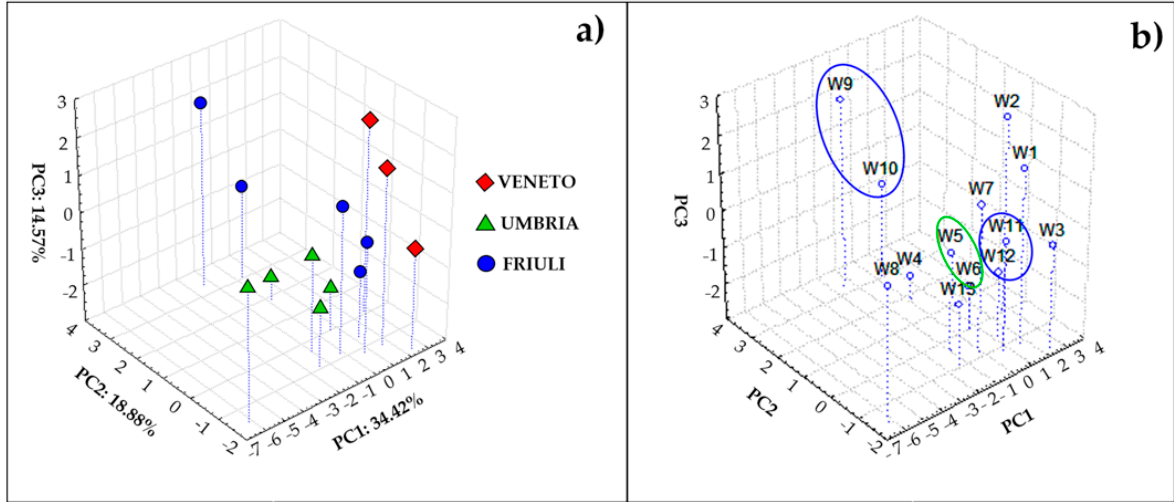
Figure 1. Scatter plot (for PC1, PC2 and PC3) obtained from PCA carried out on the element concentrations excluding from the calculation Mn, Zn, As, Al and K.; ( a ) the 3 Italian regions are indicated; ( b ) the wines names are included and some similarities discussed in the text are evidenced.